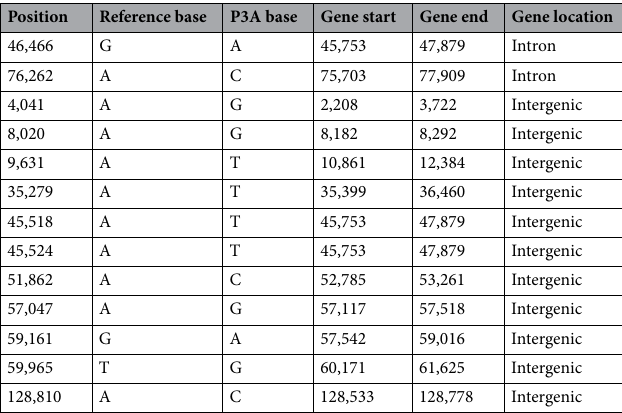
Table 3. SNPs in gene intron and intergenic region of